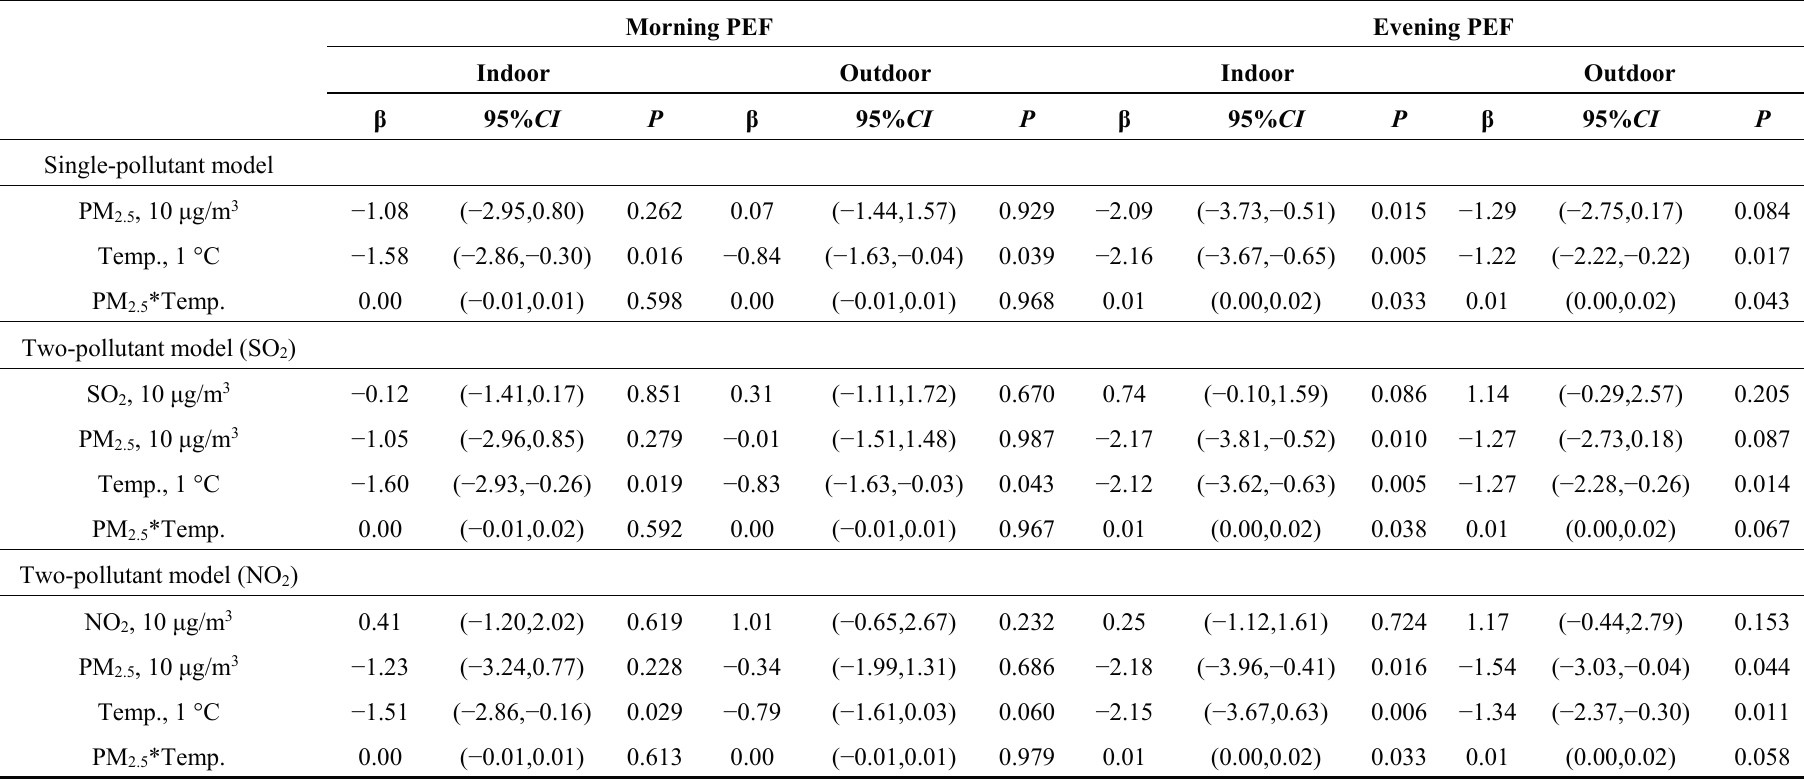
Table 4. Global analysis of the effects of PM 2.5 , temperature and interaction term on PEF. Morning PEF Evening PEF Indoor Outdoor Indoor